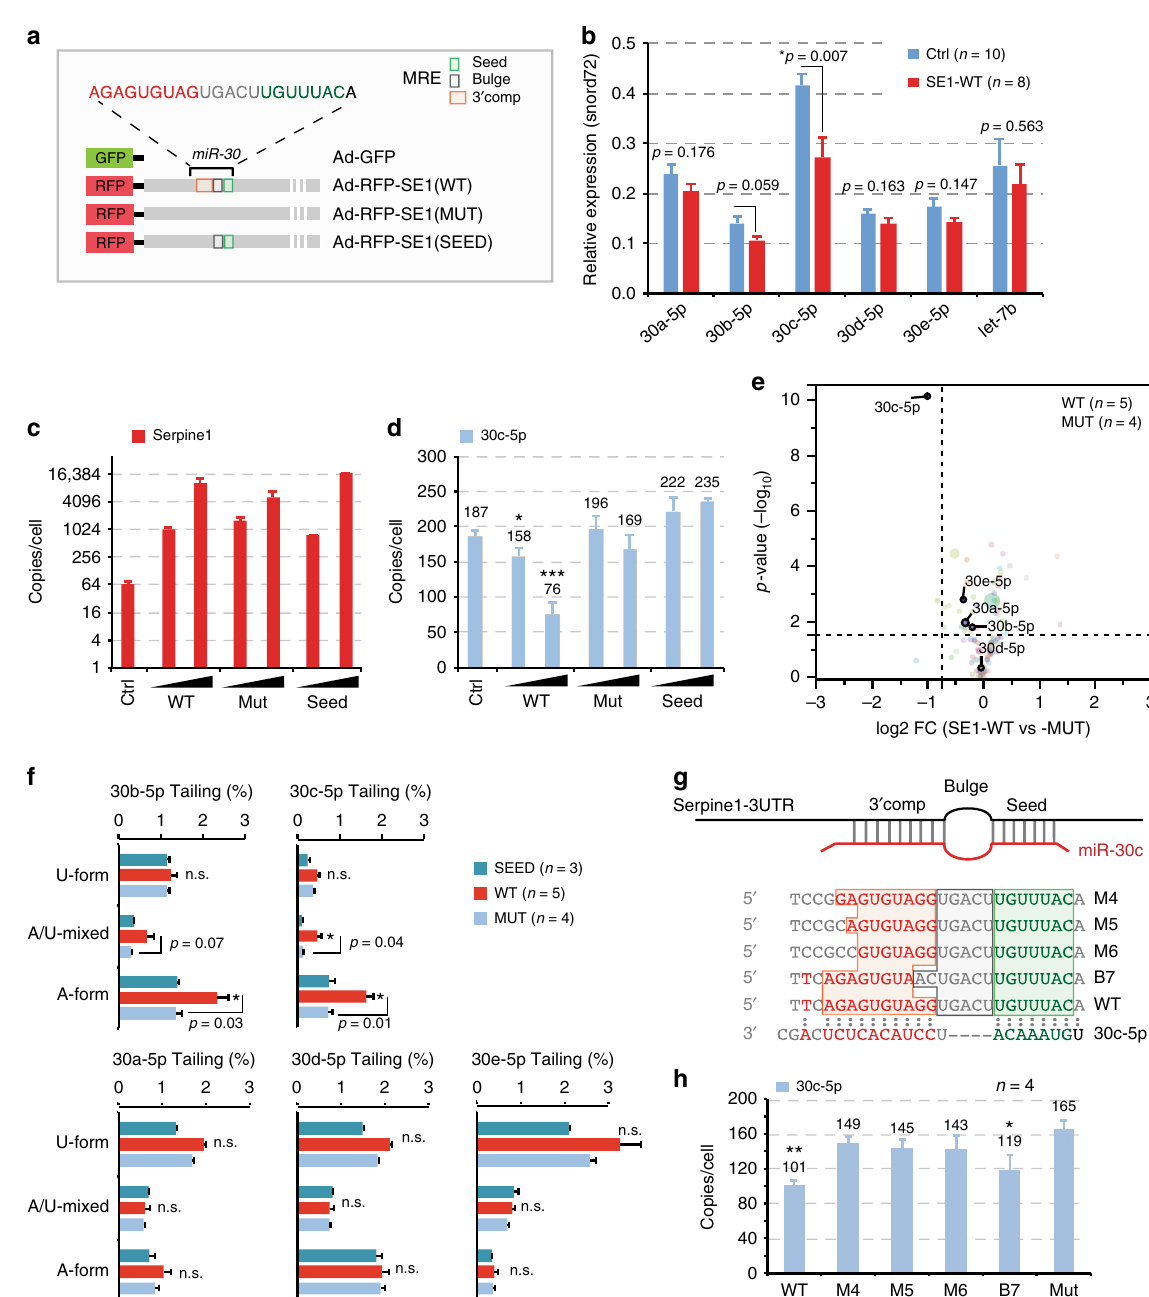
Fig. 4 Re-expression of Serpine1-MRE rescues miR-30c degradation. a Scheme of the recombinant adenoviral constructs used to re-express Serpine1 3 ′ UTR fused to an RFP reporter (rescue experiments in ( b – f )), showing the wild type form of the 3 ′ UTR of Serpine1 (WT) and two mutants, one where miR- 30 MRE had been completely abrogated (MUT) and the other where the 3 ′ supplementary site had been mutated but the seed sequence left intact (SEED). b Bar plot showing the expression of miR-30 family (and Let-7b as a control) by RT-qPCR in cells infected with control virus (Ctrl) or with Ad-RFP-SE1 (WT) adenoviruses. p -values were determined by Welch ’ s t -test. c , d Absolute expression (copies per cells) of Serpine1 3 ′ UTR transcripts and miR-30c-5p measured by RT-qPCR in the rescue experiments. Adenoviruses were expressed at two different multiplicity of infection (MOI ~1 and ~5). Asterisks mark signi fi cant values (* p < 0.05, *** p < 0.001; Welch ’ s t -test) e sRNA-seq was performed to measure miRNA expression in MRE-KO cells that express a wild type (WT, n = 5) or a mutated (MUT, n = 4) 3 ′ UTR of Serpine1. The graph shows the average log 2 FC ( x -axis) and the p -value ( – log 10 , y -axis) by Welch ’ s t - test. Colour coding re fl ects different miRNA families. f Frequency (%) of tailing events, distinguished as adenylated (A-), uridylated (U-), or mixed isomiRs (A/U-mixed), as measured by sRNA-seq. p -values by Welch ’ s t -test. g Scheme of the mutant Serpine1 constructs (see also Methods) that were used to dissect TDMD 3 ′ pairing rules ( h ). Seed in green and 3 ′ supplementary pairing in orange. h Absolute expression (copies per cells) of miR-30c-5p measured by RT-qPCR upon over-expression of different Serpine1 mutants (shown in ( g )). Cells were collected at 36 h after transfection (* p < 0.05, *** p < 0.01, Welch ’ s t